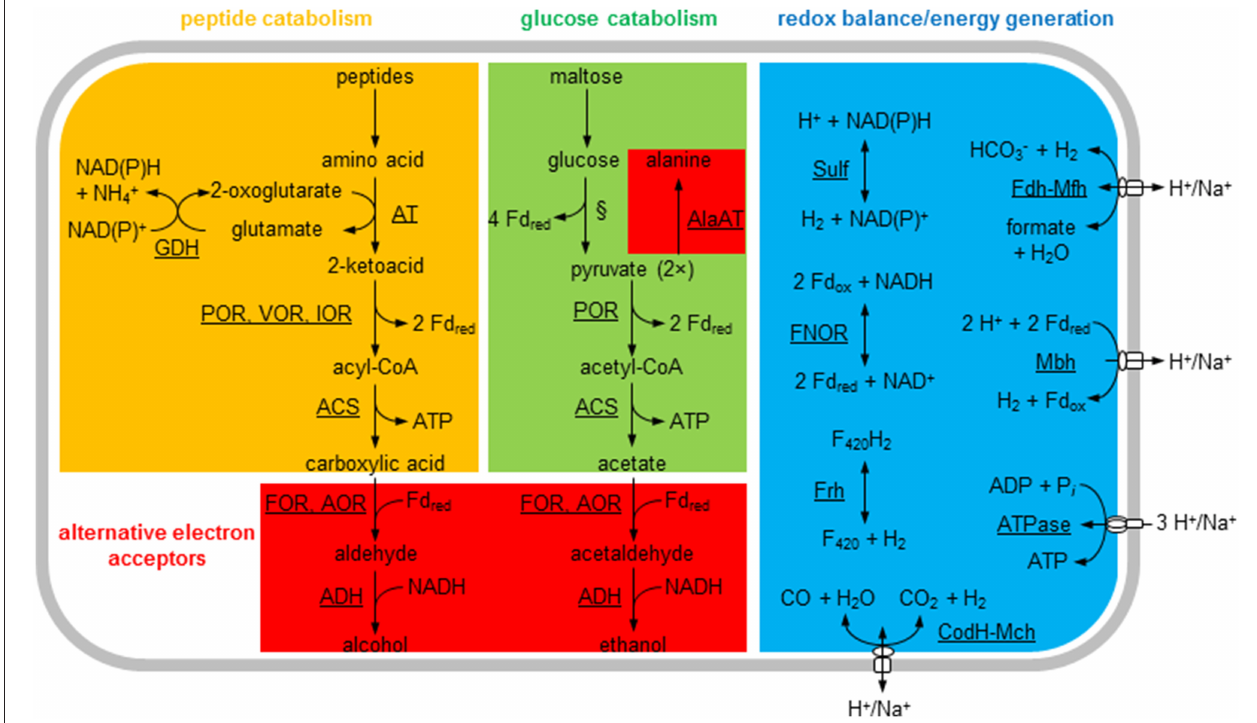
FIGURE 1 | General metabolic pathways for Thermococcus paralvinellae . The enzymes are membrane-bound hydrogenases: Fd-dependent (Mbh), formate-dependent (Mfh), and CO-dependent (Mch); cytoplasmic hydrogenases: NADH-dependent (Sulf) and F 420 -dependent (Frh); NADH:Fd oxidoreductase (FNOR); membrane-bound ATP synthase (ATPase); glutamate dehydrogenase (GDH); alanine aminotransferase (AlaAT); general aminotransferases (AT); pyruvate:Fd oxidoreductase (POR); isovalerate:Fd oxidoreductase (VOR); indolepyruvate:Fd oxidoreductase (IOR); ADP-forming acetyl-CoA/acyl-CoA synthetase (ACS); aldehyde:Fd oxidoreductase (AOR); formaldehyde:Fd oxidoreductase (FOR); and alcohol dehydrogenase (ADH). Fd, electron carrier ferredoxin; F 420 , electron carrier coenzyme F 420 ; § , modified Embden-Meyerhof pathway. The activities for most of the enzymes listed are shown in Table 4